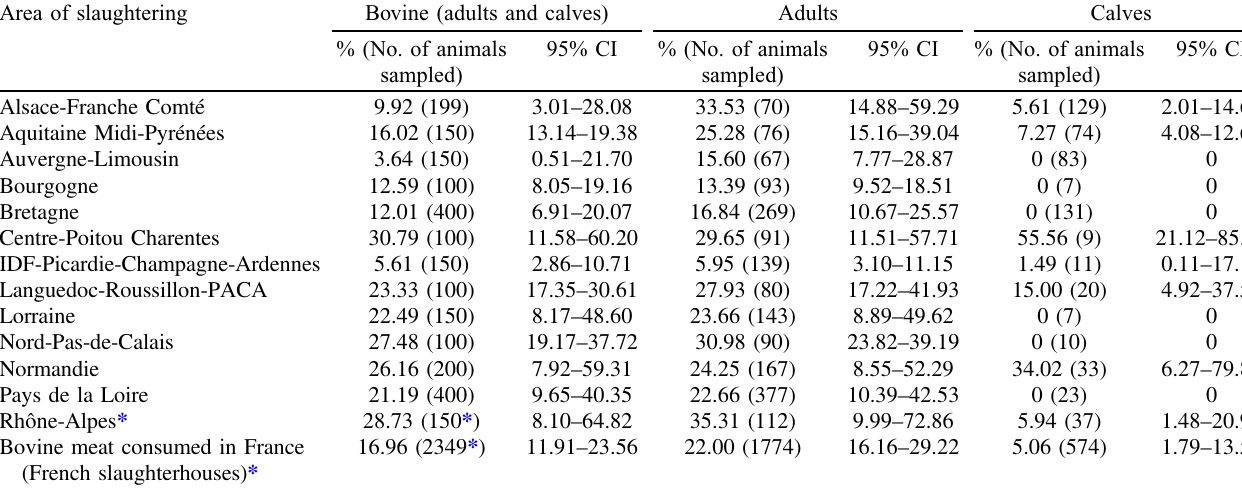
Table 5. Seroprevalence of Toxoplasma gondii infection (cut-off titer 6) in bovine meat consumed in France by area of slaughtering. Area of slaughtering Bovine (adults and calves) Adults Calves % (No. of